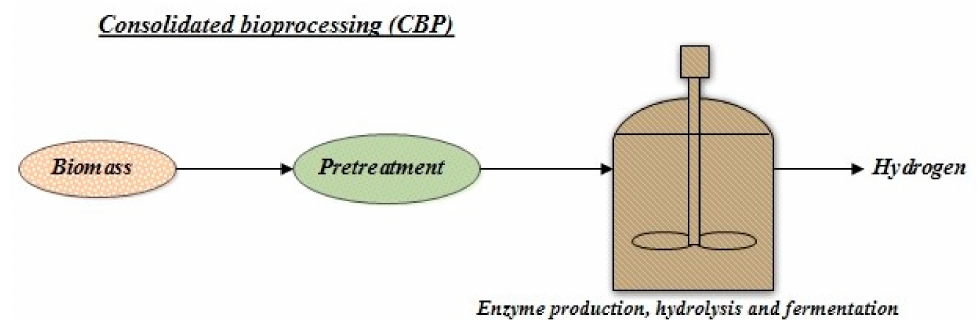
Figure 7. Process outlook of consolidated bioprocessing (CBP) for hydrogen